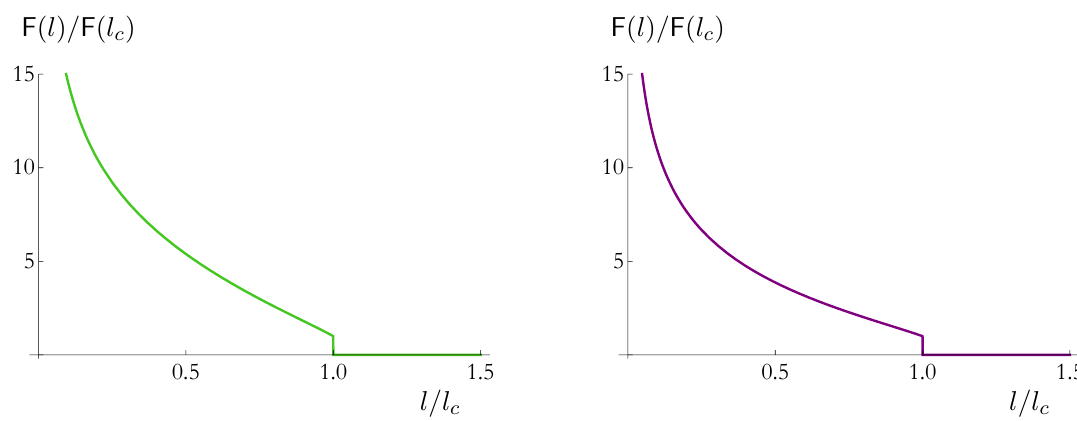
Figure 5. Function F ( l ) for a single strip as a function of strip width in the gapped non-confining theory B 0 (Left) and the confining one B conf (Right). Both quantities are normalized to their 8 8 value at the point where the “disconnected” configuration t becomes dominant, above which it is strictly zero.